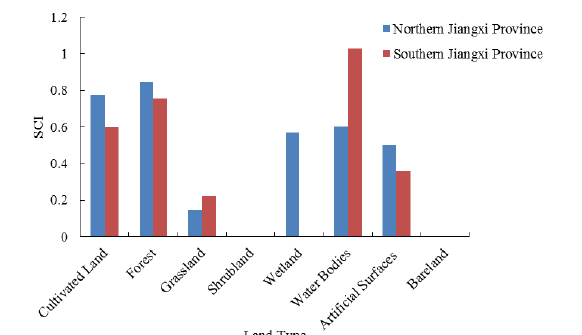
Figure 6. Shape consistency coefficient of different land types for GlobeLand30 and China land use data in Jiangxi province